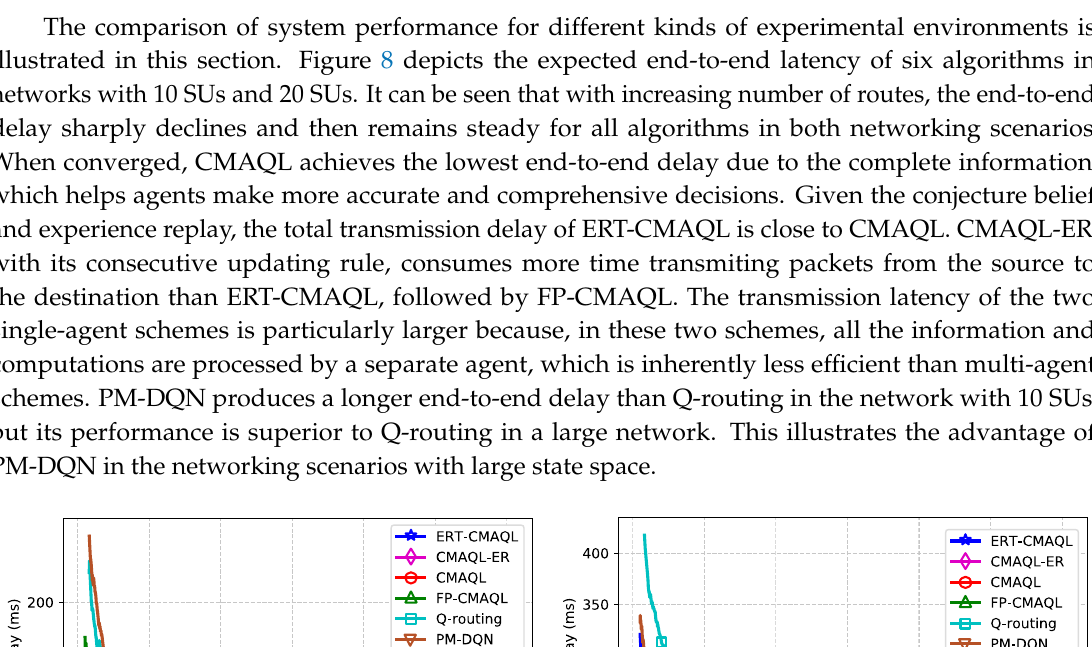
Figure 7. Network topology consisting of 20 SUs and 10 PUs.